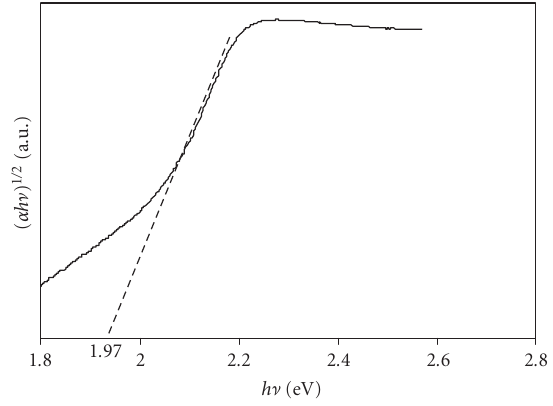
Figure 5: ( αhυ ) 1 / 2 versus hυ curve for Zn-dotted α -Fe 2 O 3 (sample E).